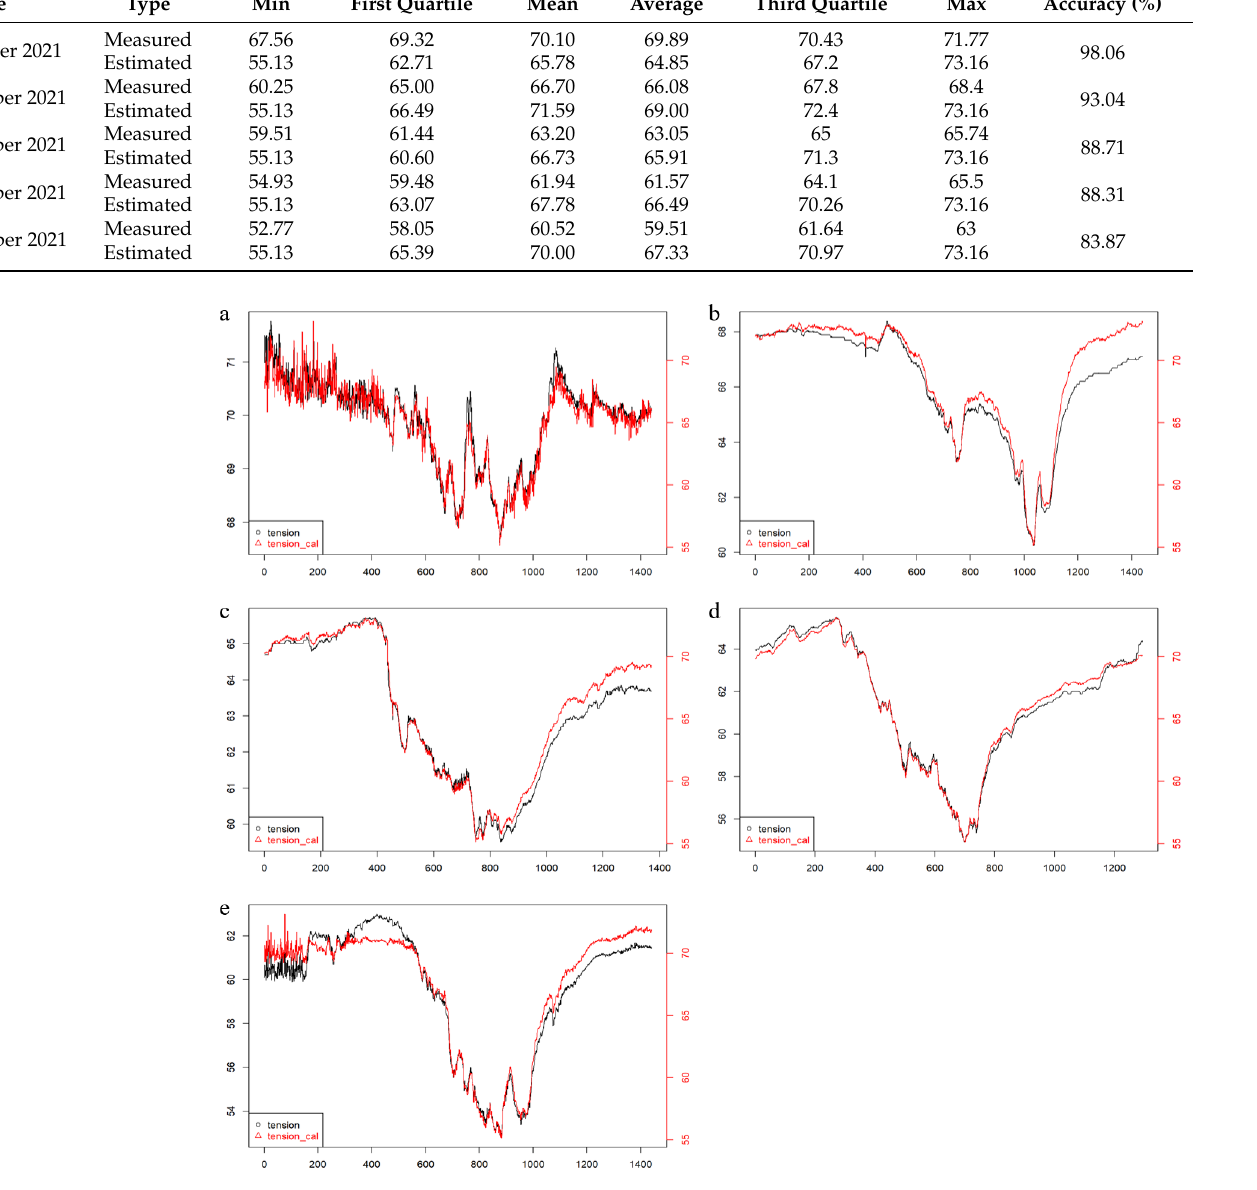
Figure 9. Estimated vs. actual tension of overhead wire: ( a ) 7 September 2021; ( b ) 10 September 2021; ( c ) 13 September 2021; ( d ) 16 September 2021; ( e ) 21 September